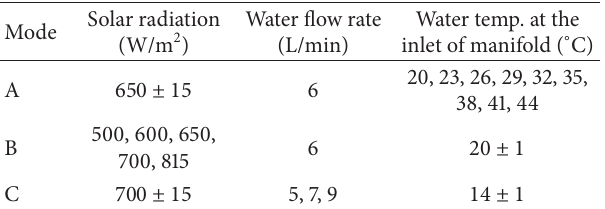
Table 2: List of testing